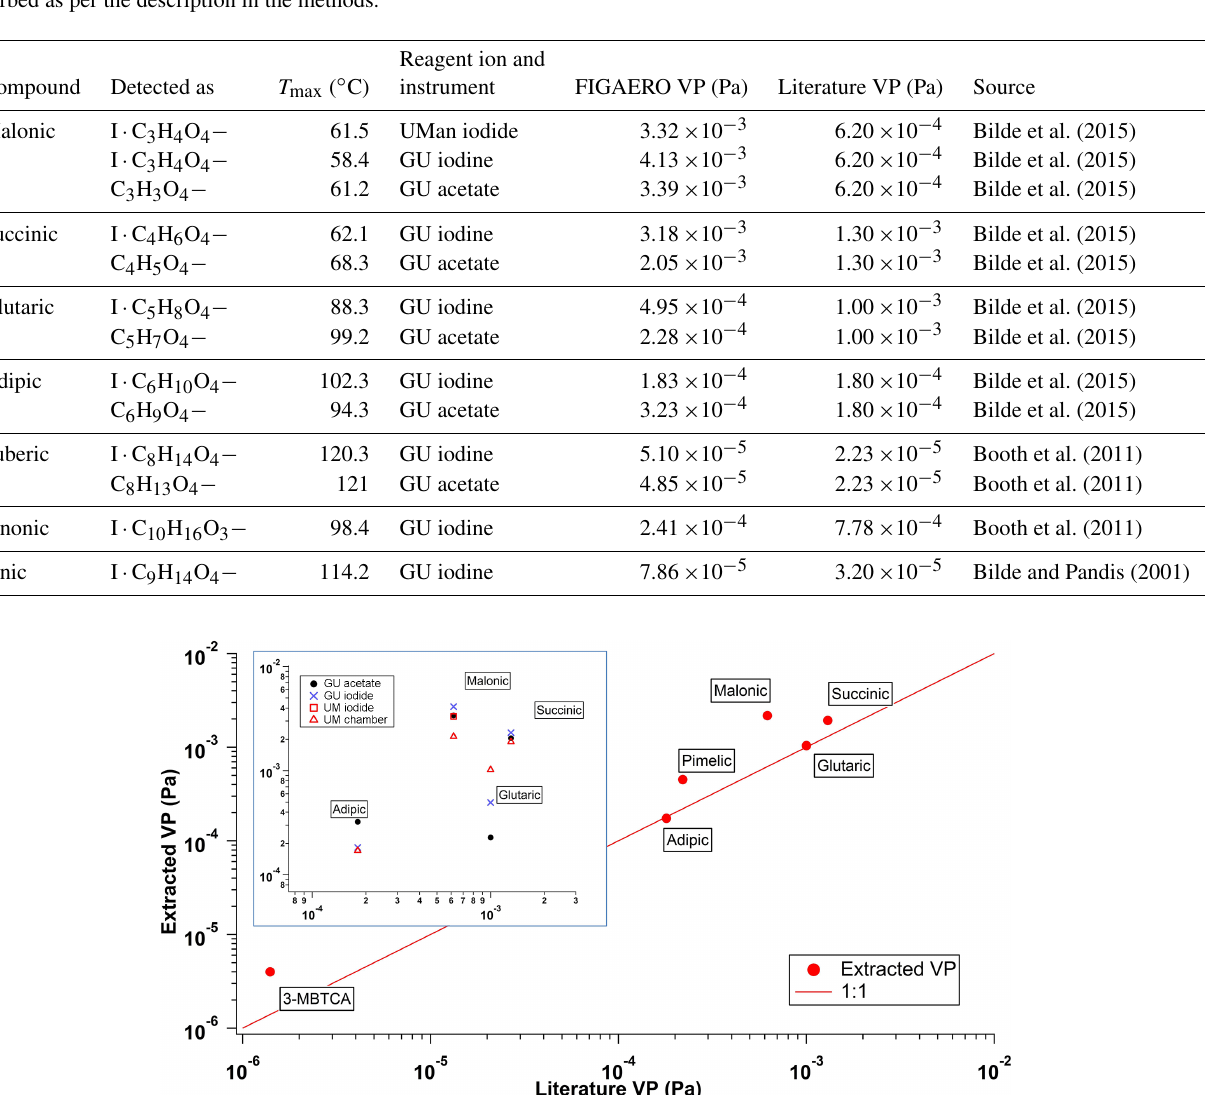
Table 2. Extracted T max values and calculated VPs through utilization of the PEG calibration compared against literature data of subcooled saturation vapour pressures. A single-component measurement is defined as a single calibration compound being placed on the filter and desorbed as per the description in the methods.